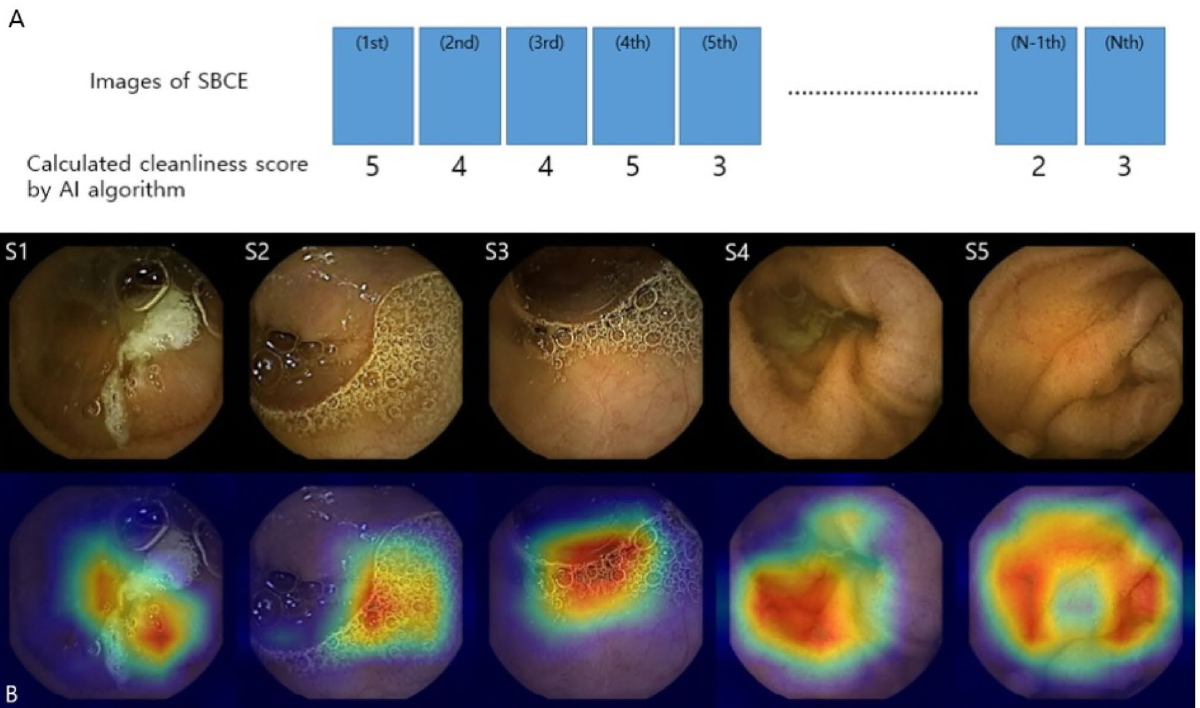
Figure 5. Real example of small bowel cleanliness score calculated by the artificial intelligence (AI) algorithm in a small bowel capsule endoscopy case (Case No. 60). ( A ) The small bowel cleanliness was scored from 1.0 (S1) to 5.0 (S5). ( B ) The image analysis by AI algorithm was expressed in a Grad-CAM visualization